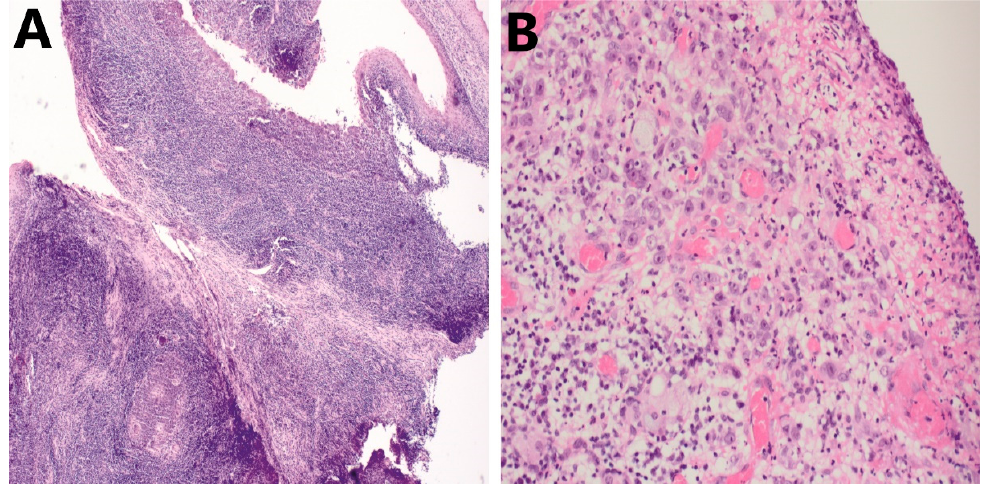
Figure 3. Examples of pitfalls during assessment of TILs in HNSCC on HE. ( A ) Presence of pre- existing lymphoid tissue in HNSCC; 10 × ( B ) Presence of ulcerations seeded with polymorphonuclear cells (granulocytes); 20 × . HNSCC, head and neck squamous cell carcinoma; TILs, tumor-infiltrating lymphocytes.